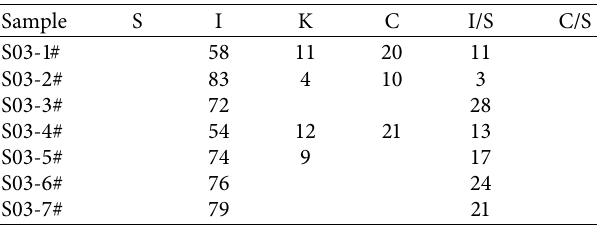
Table 4: X-ray diffraction analysis of clay